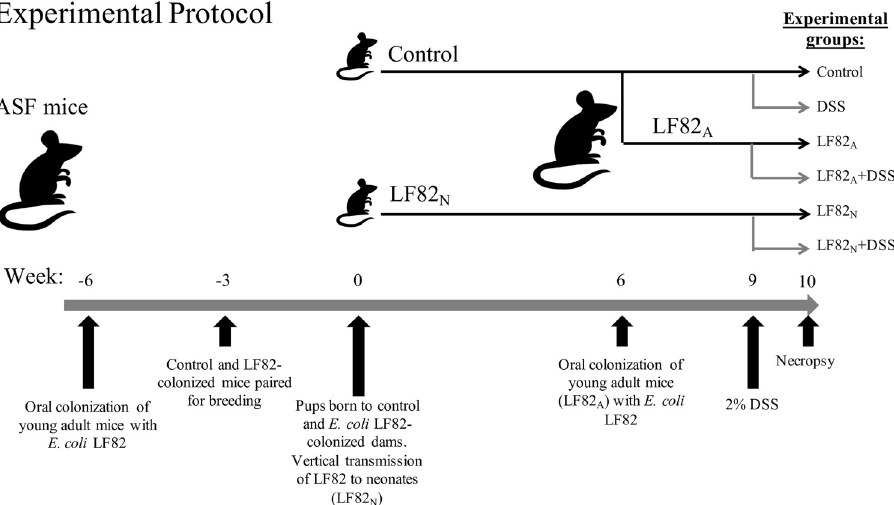
Fig 1. Experimental protocol. Adult gnotobiotic C3H/HeN mice harboring the altered Schaedler flora (ASF) were orally gavaged with E . coli LF82. After three weeks, LF82-infected and ASF-only control mice were paired for breeding. Pups born to E . coli LF82-infected dams were colonized by vertical transmission during the process of microbial succession and were designated as neonatal colonized (LF82 N ). LF82 N and ASF-only pups were weaned after 3 weeks of age. At 6 weeks of age, a subset of ASF-only mice were colonized with E . coli LF82 by oral gavage and designated as adult colonized (LF82 A ). At 9 weeks of age, mice were treated with filter sterilized 2% dextran sodium sulfate in their drinking water for seven days prior to